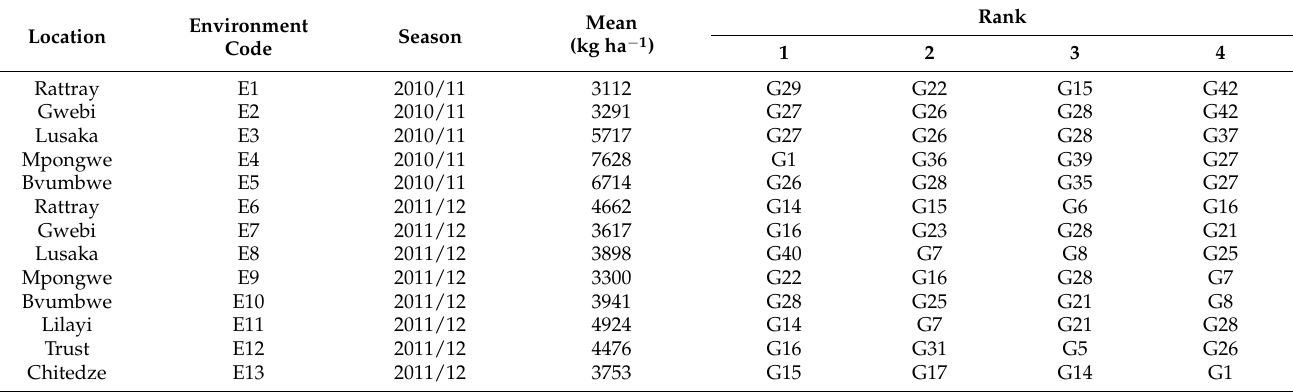
Table 4. Ranking of the first four AMMI selections per environment for grain